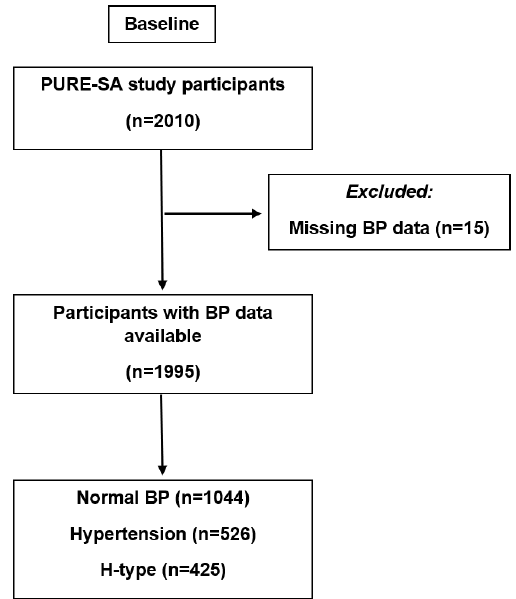
Figure 1. Study design flow chart.